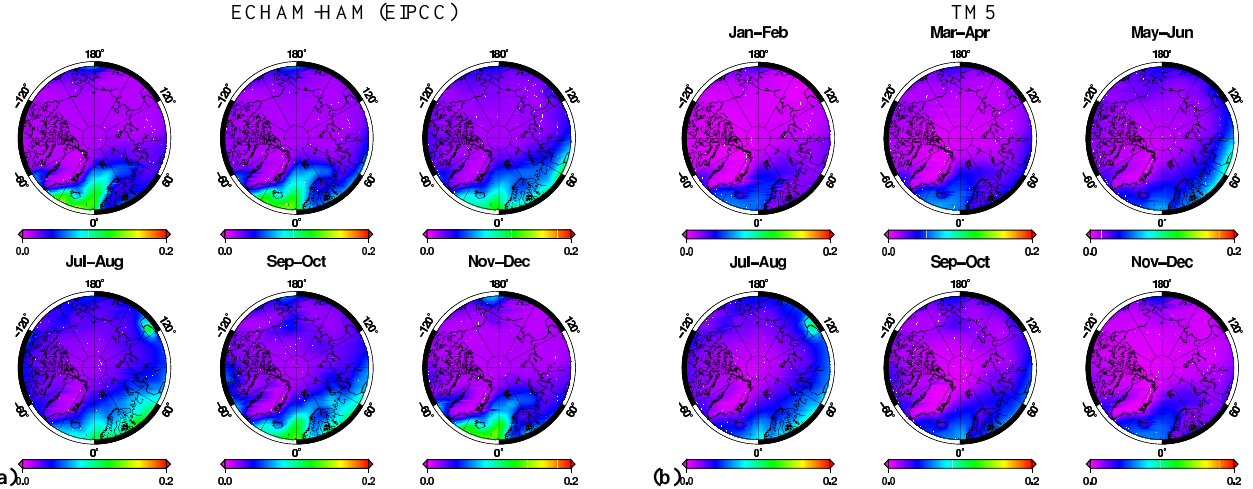
Fig. 6. Maps of average AOD in different periods of the year. Monthly means are calculated in the period 2003 to 2006, common to all datasets. Panels: (a) ECHAM-HAM (EIPCC emissions), (b) TM5. ECHAM-HAM (EIPCC) + wet dep. mod. ECHAM-HAM (EGFED) + wet dep. mod.